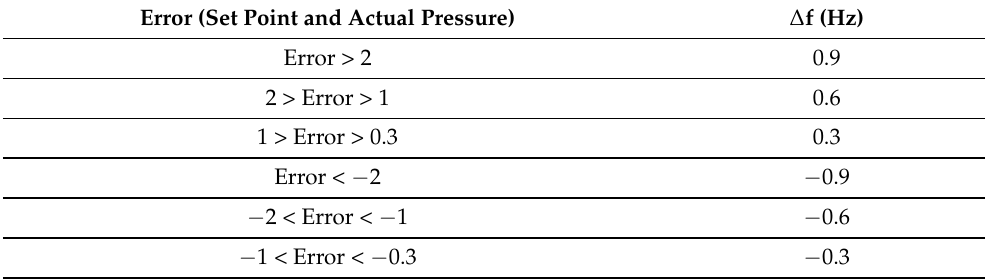
Table 1. Current control logic.